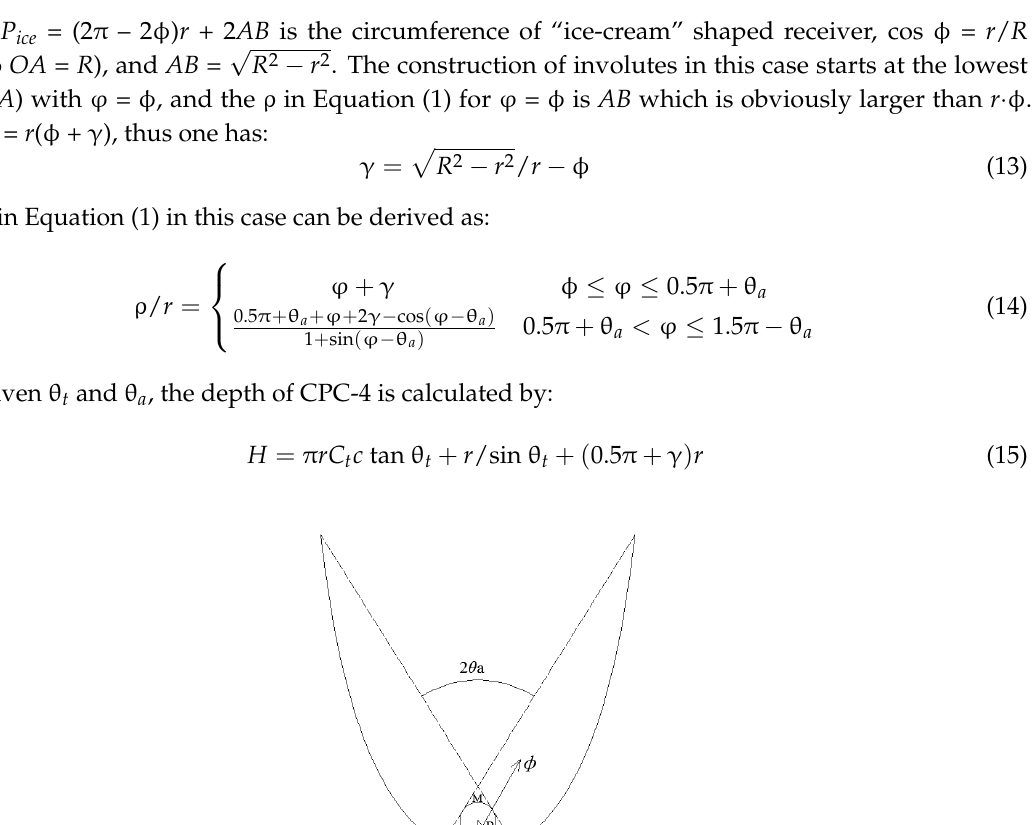
Figure 5. CPC ‐ 4, designed based on an “ice ‐ cream” absorber.